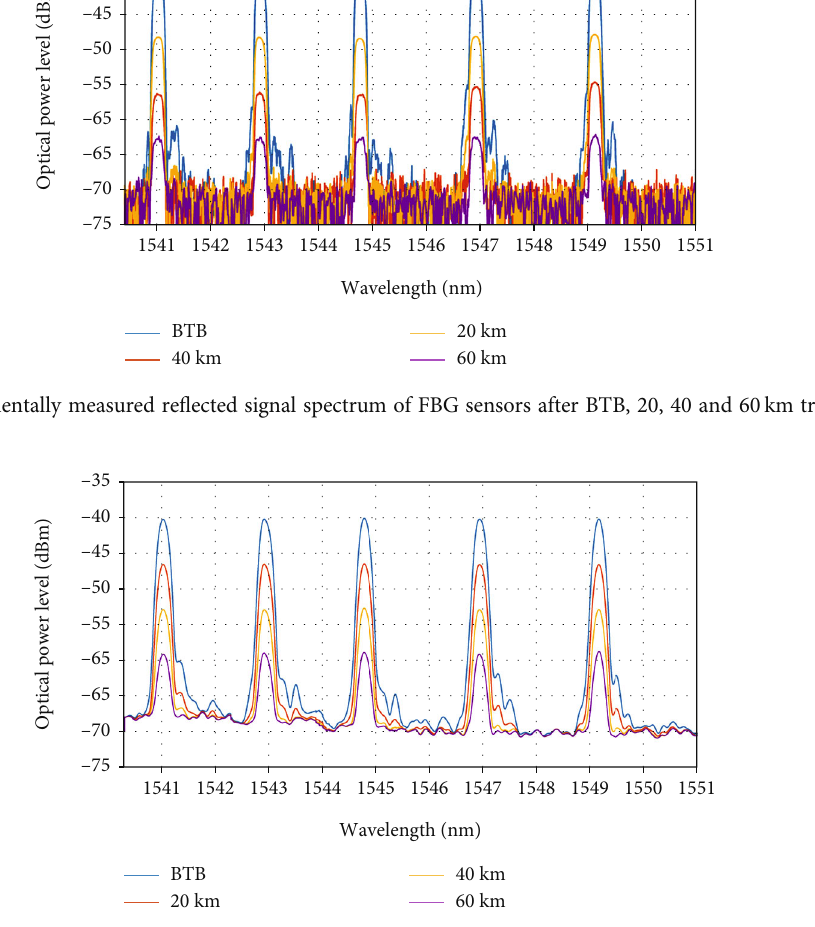
Figure 16: Mathematical simulation ’ s measured re fl ected signal spectrum of FBG sensor after BTB, 20, 40, and 60 km